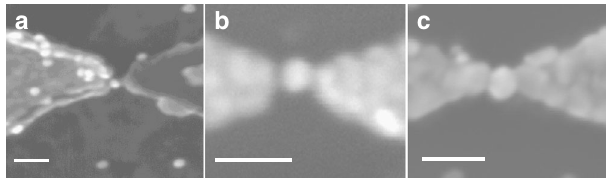
Fig. 6 Scanning electron microscope (SEM) images of different coupled systems. SEM images of samples after: a Trapping a gold nanoparticle into the gap. b Applying the electrodeposition process but before any current could be measured through the dot. c After the sample was fully connected by electrodeposition and the dot becomes part of the electrodes. All white scale bars represent 100